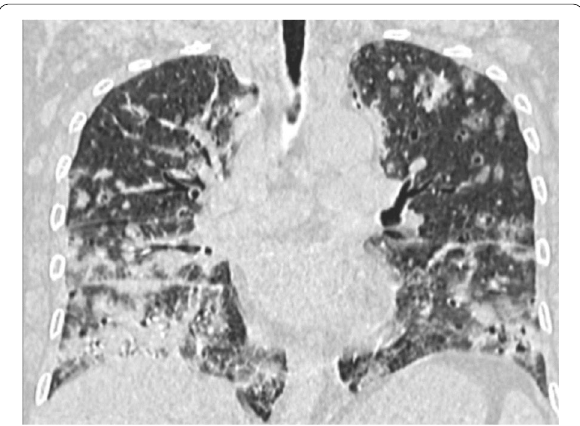
Fig. 2 HRCT chest coronal section shows diffuse multiple cavitating nodules with consolidation in both lower